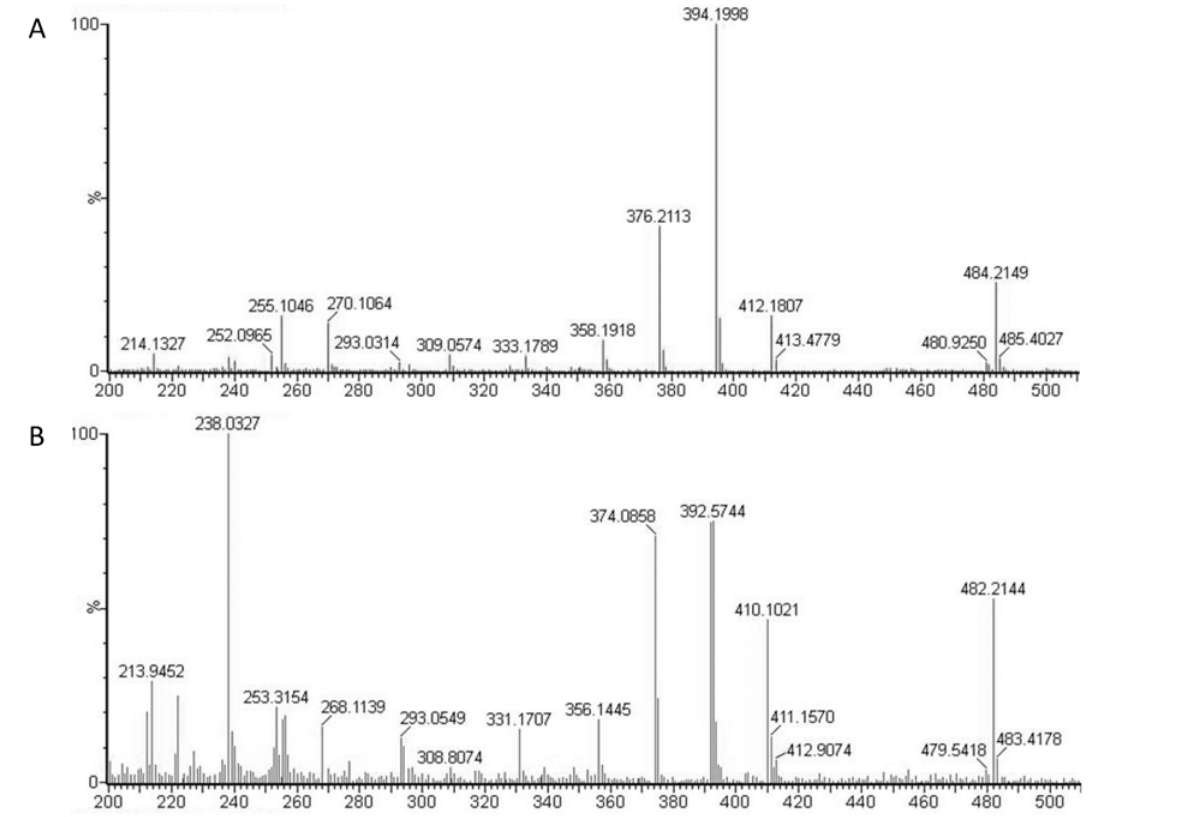
Fig 3. Fragmentation pattern of diaphorin and the diaphorin-related compound.